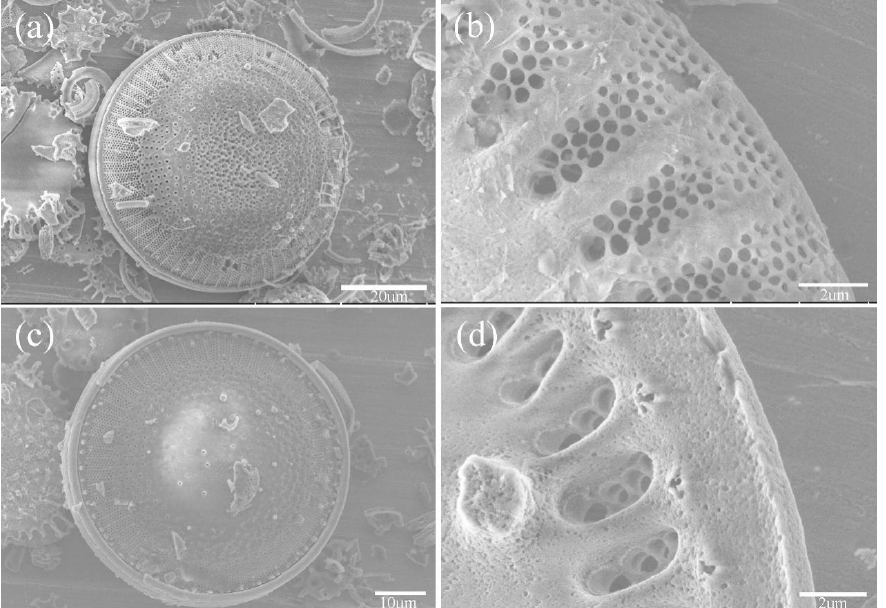
Figure 3. SEM images of DA before ( a , b ) and after ( c , d ) crosslink β -CD. The XRD patterns of DA and DA/ β -CD were presented in Figure 4. The obvious dif- fraction peaks of the DA and DA/ β -CD were observed at 21.6°, 26.8°, 29.5° and 35.9° (2θ), due to the reflection of silica. The new peaks were observed at 14.2° and 43.2° from DA/ β - CD compared with DA, which proved that β -CD was grafted to the surface of DA [42]. The XRD patterns indicate weaker crystallization and a larger proportion of amorphous phase for DA/ β -CD. The amorphous phase could improve the permeability of the target molecule, and bring higher adsorption capacity.